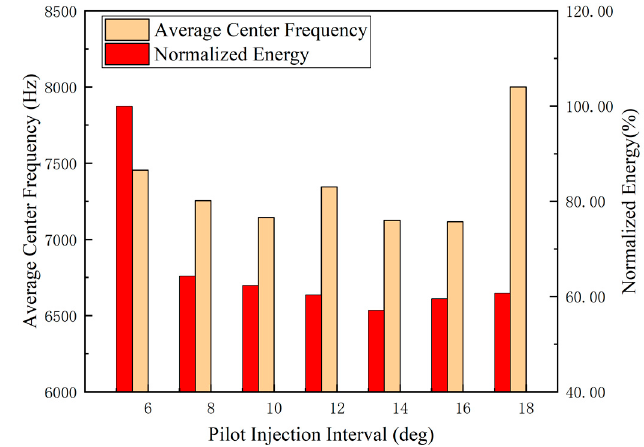
Figure 24. Average center oscillation frequency and the normalized average oscillation energy under different pilot injection interval.